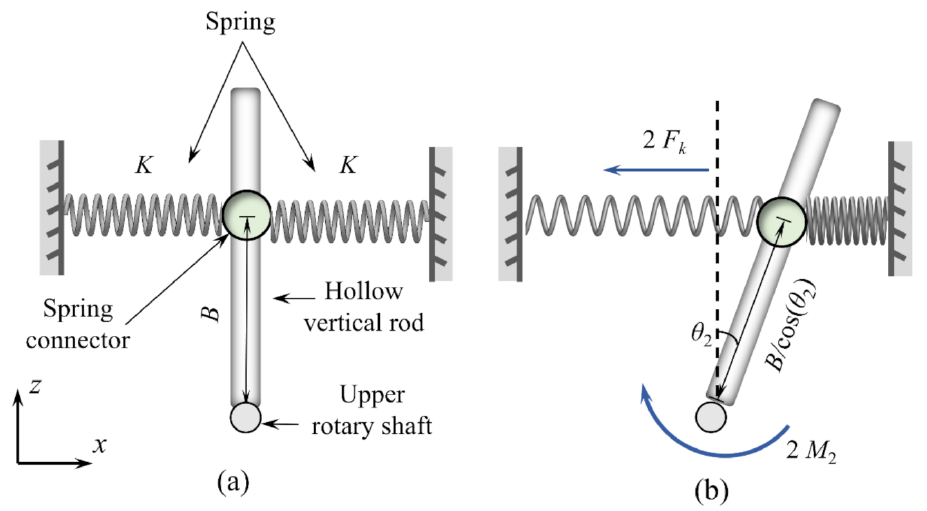
Figure 3. Force analysis of restoration system: ( a ) Equilibrium position; ( b ) Force after rotation angle θ 2